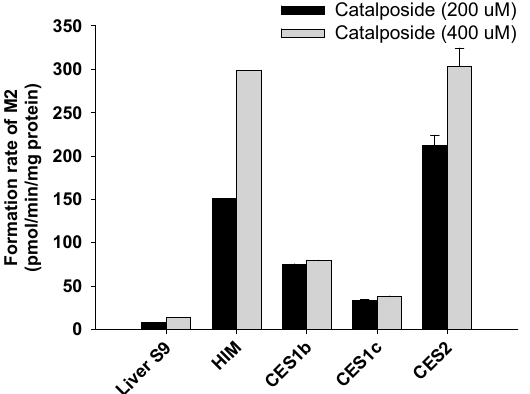
Figure 8. Rates of formation of 4-hydroxybenzoic acid (M2) from 200 µ M and 400 µ M catalposide in human liver S9 fractions (Liver S9); human intestinal microsomes (HIM); and human cDNA-expressed CES1b, CES1c, and CES2 enzymes. All data are means ± SD ( n = 3).